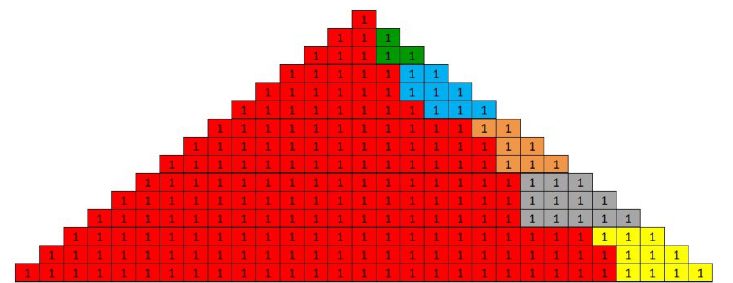
Figure 5. Need fulfillment degrees based on the expert opinions of government administrators. Source: own study. Color markings as in Figure 3.